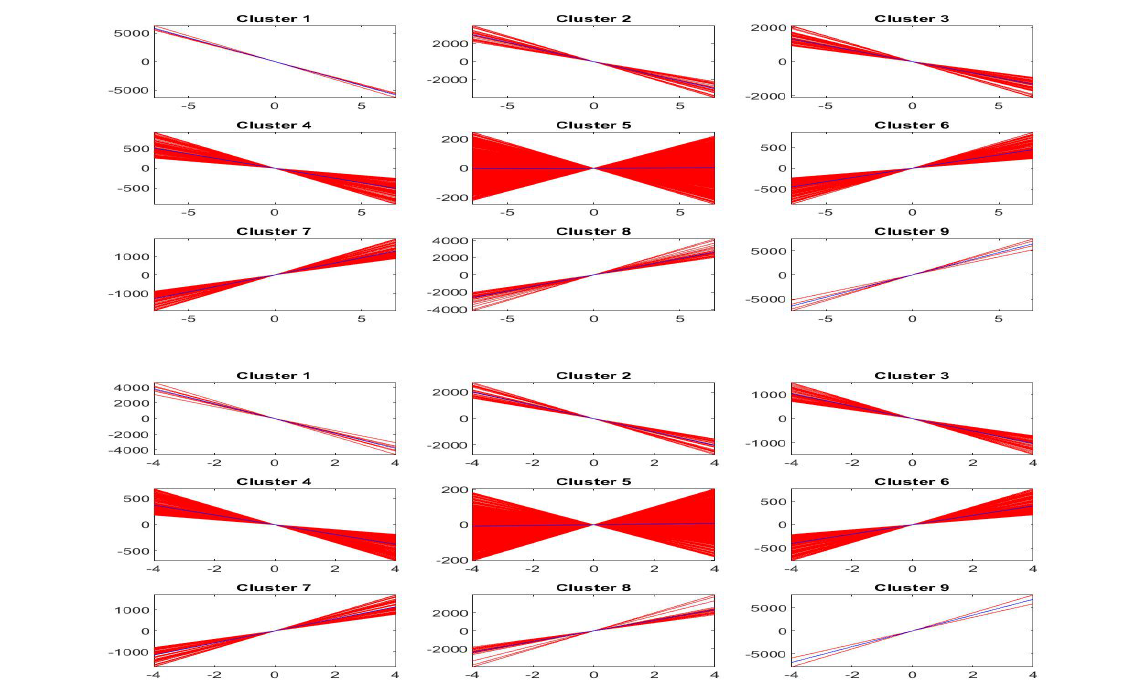
Figure 17. Clustering of L 2 -norm F-transform components (polynomials) of order 1 for Bitcoin series. The clusters correspond to the fuzzy r -partition P a with r = 4 ( bottom picture) and r = 7 ( top ).